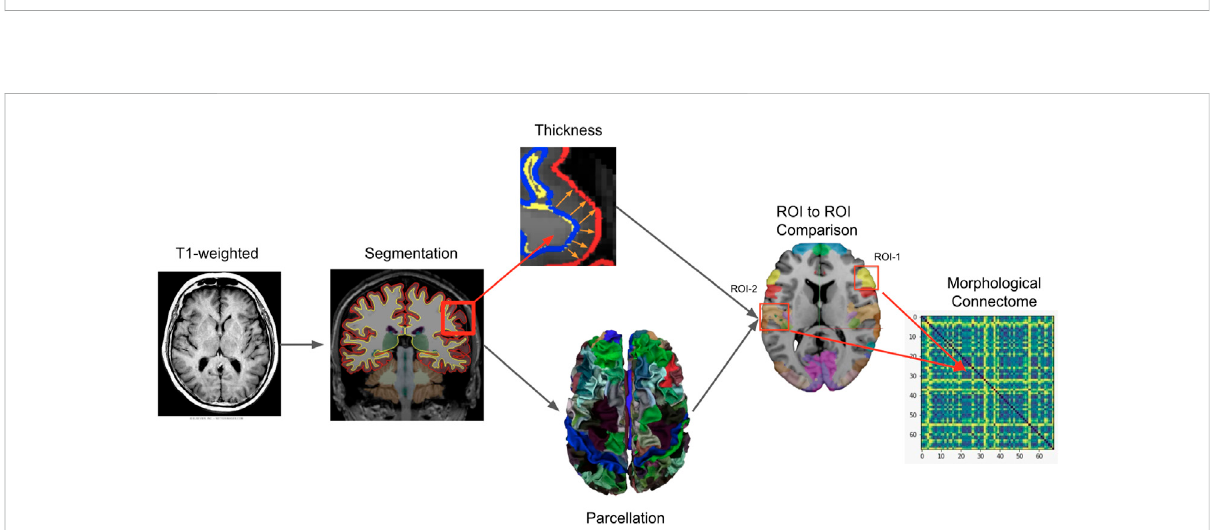
FIGURE 2 Intuitive representation of the pipeline implemented for morphological connectome data generation. Starting from the magnetic resonance T1-weightedimageofapatient,theGMtissuewas fi rstsegmentedandthenparcelledindifferentanatomicalbrainregions(ROIs)basedonaspeci fi c atlas used as template (FSAverage or Glasser 2016). Additionally, from the segmented tissue, the thickness morphometricstatisticwas calculated for each GM region. A ROI to ROI binary comparison was performed for all possible combinations of GM regions (one to one comparison). The Manhattan distance formulation was used as dissimilarity metric. The results were organized in a squared symmetric adjacency matrix (i.e. connectome) where each entry represent the (dis-)similarity between two ROIs. From the connectome, six global metrics were calculated for the analysis of graph